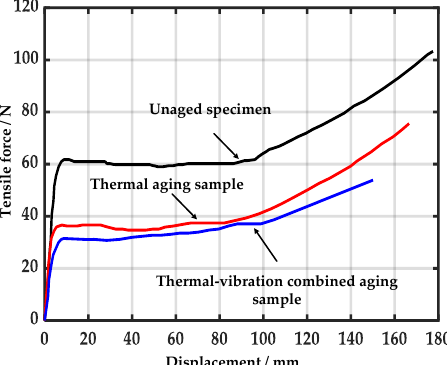
Figure 10. Tensile test results of XLPE samples under 1440 h aging [55]. The black curve indicates the specimen without aging, the red curve indicates the thermal aging specimen, and the blue curve indicates the combined thermal-vibration aging specimen. The mechanical stress generated by vibration will cause the aging of XLPE, which makes the XLPE specimen less elastic and easy to be destroyed.